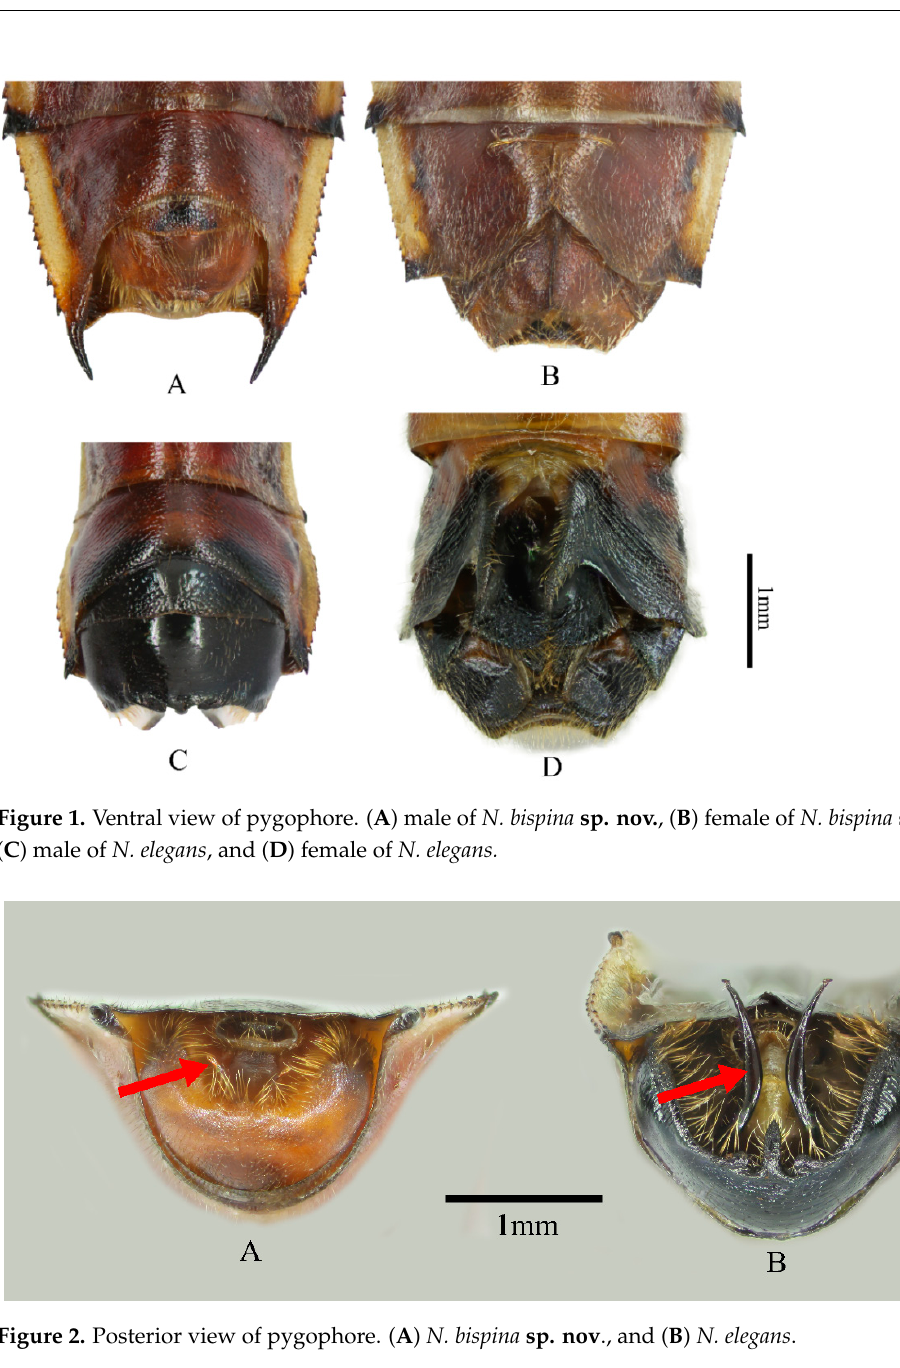
that the match of females and males for both species was